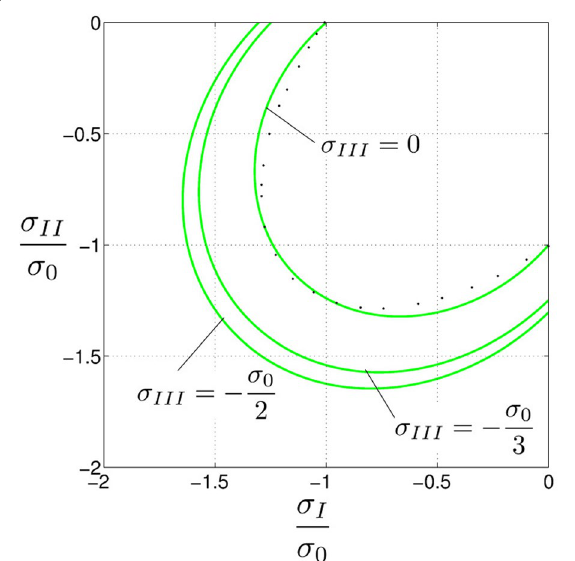
Fig. 2 Yield function evolution with the out-of-plane stress component (Eq. (7)), the black dots correspond to data reported in Comi (2001), obtained for plane stress.